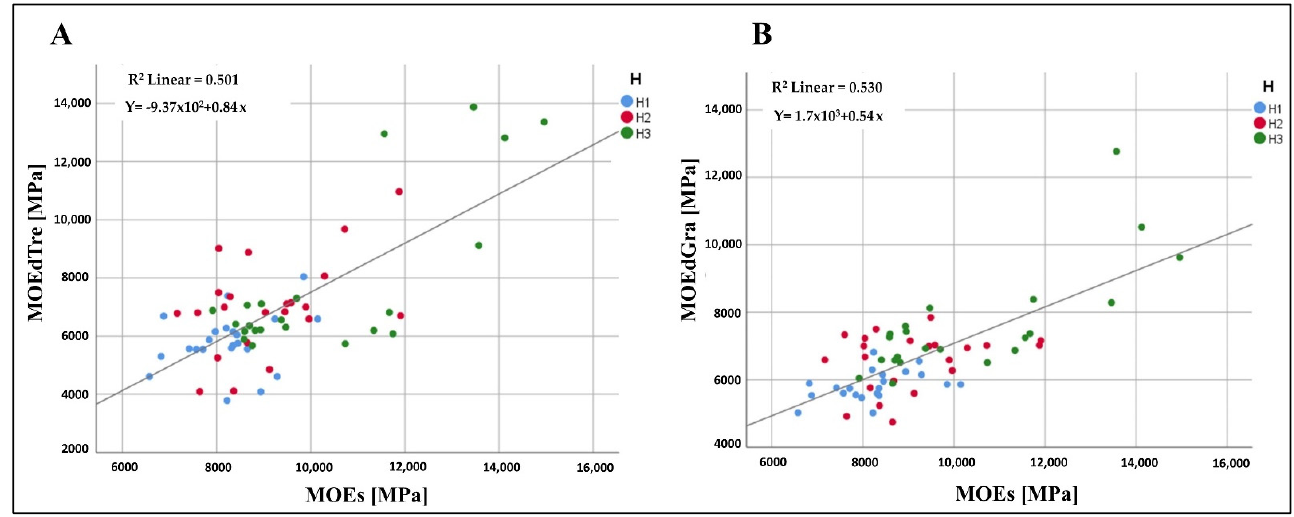
Figure 5. The relationships between the static modulus of elasticity and the dynamic modulus of elasticity obtained from standing trees ( A ) and logs ( B ).